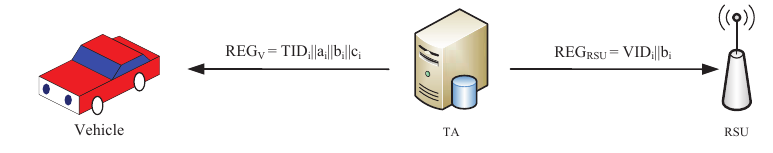
Figure 4. Vehicle and RSU